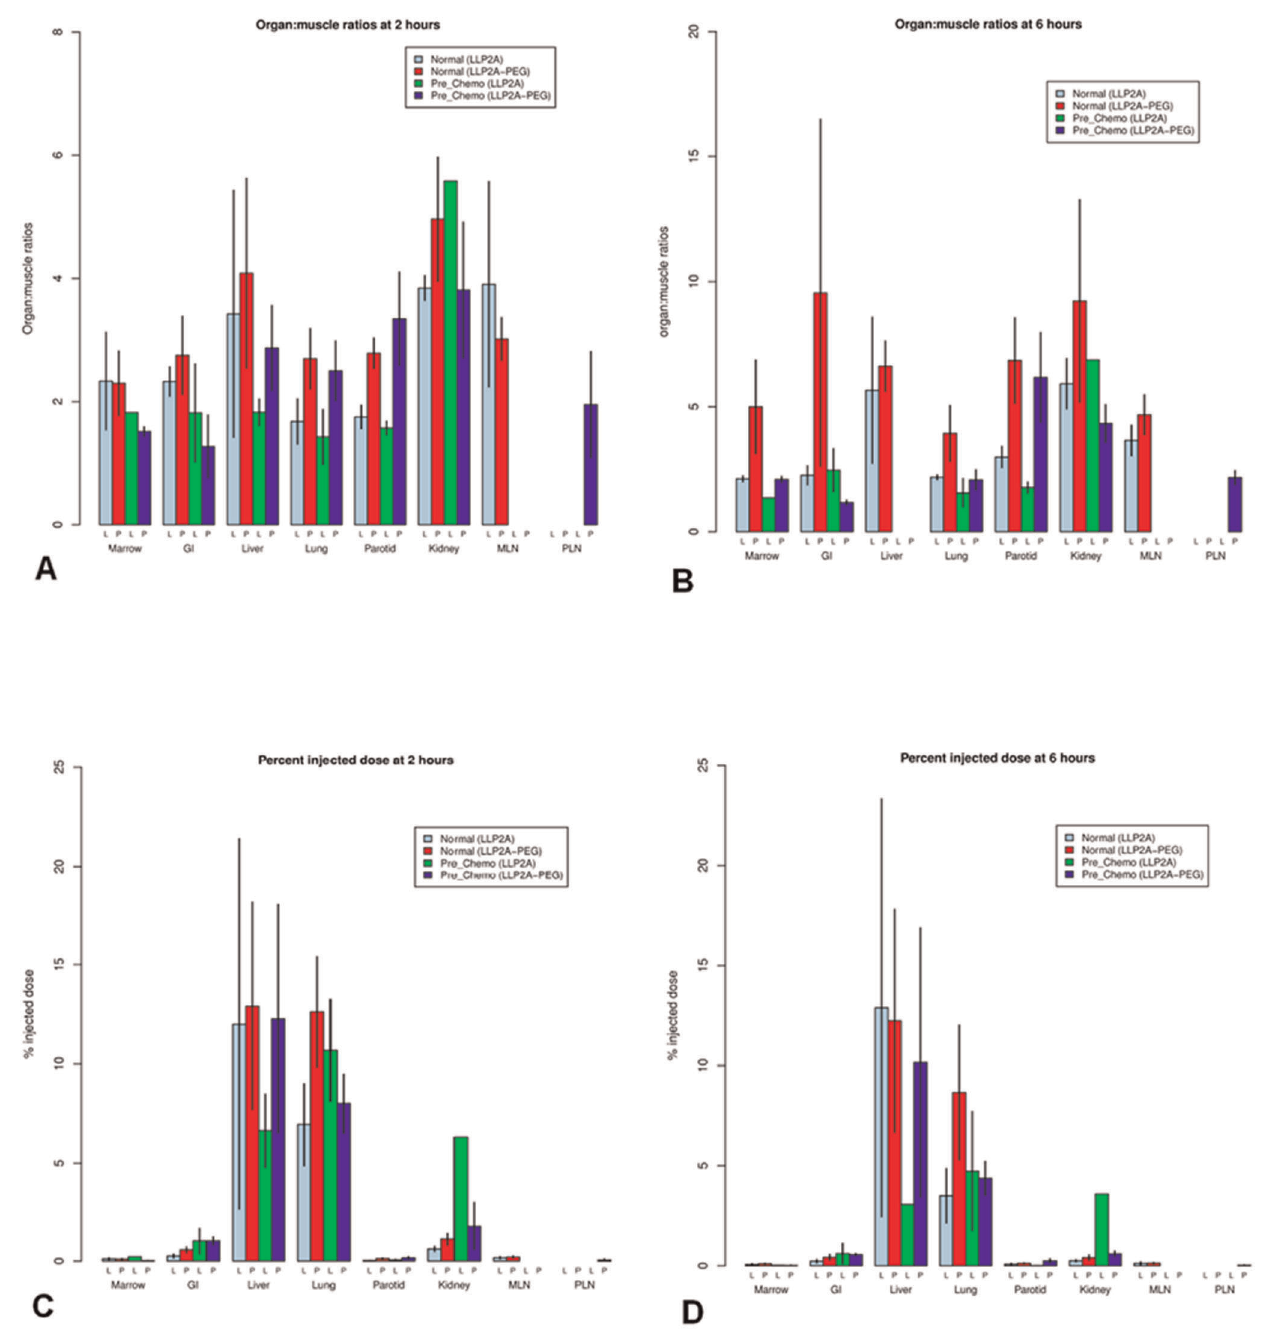
Figure 4. Biodistribution patterns of 99m Tc-LLP2A-HYNIC and 99m Tc-LLP2A-HYNIC-PEG in normal dogs and dogs with lymphoma (unaffected tissues) prior to chemotherapy treatment. Mean( 6 SE) organ:muscle ratios of 99m Tc-LLP2A-HYNIC and 99m Tc-LLP2A-HYNIC-PEG at 2 hours post injection (A) and 6 hours post injection (B).Percent injected dose (PID) of 99m Tc-LLP2A-HYNIC and 99m Tc-LLP2A-HYNIC-PEG at 2 hours post injection (C) and 6 hours post injection (D). Gastrointestinal tract (GI), mandibular lymph node (MLN), popliteal lymph node (PLN).